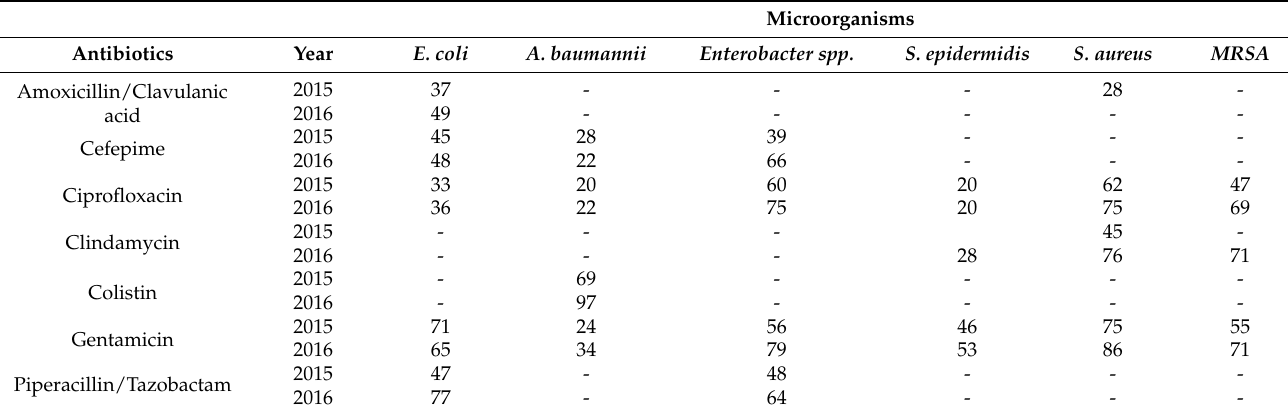
Table 1. Hospital antibiogram data (2015–2016) showing the percentage of sensitive susceptibilities between specific microorganisms (columns) and antibiotics (rows).